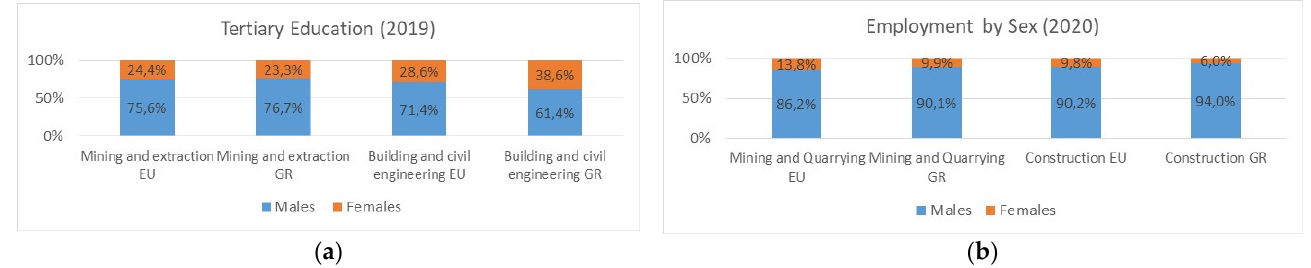
Figure 1. Percentages of women ( a ) in tertiary education in 2019 and ( b ) in employment in 2020 (down). Source: [1,4] (authors’ own editing process).